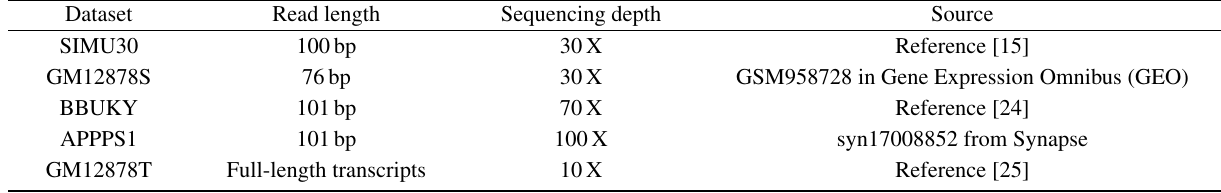
Table 1 Summary information of datasets used in this